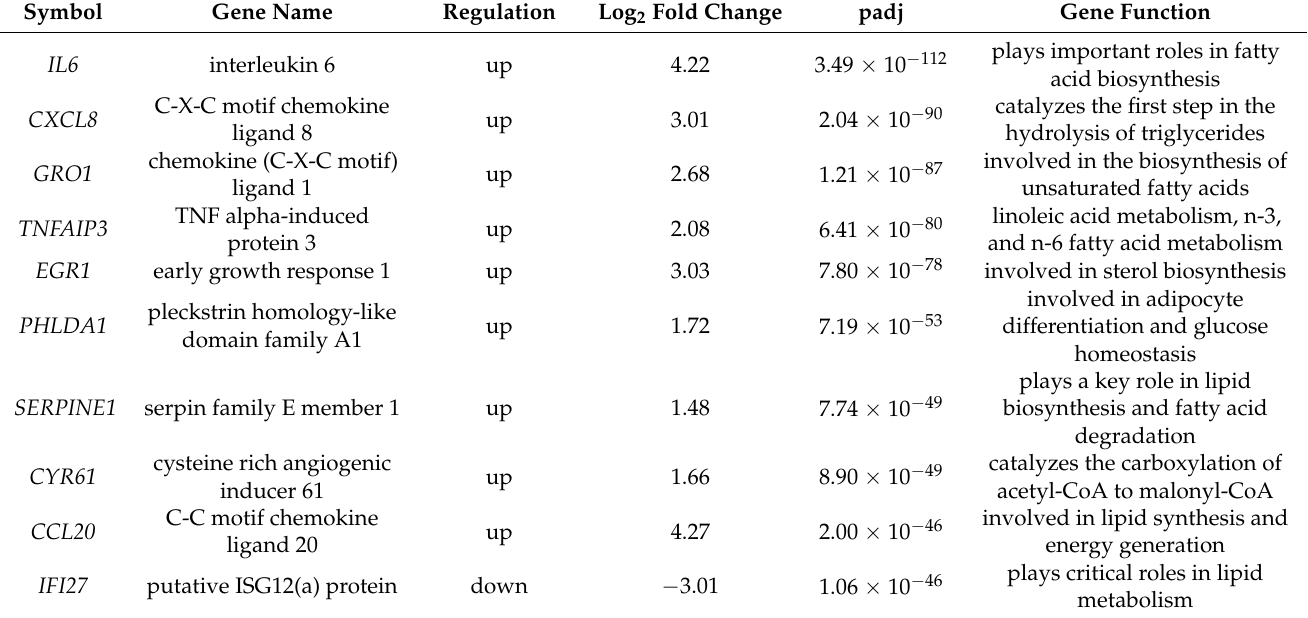
Table 3. Top 10 differentially expressed genes between knockdown and control